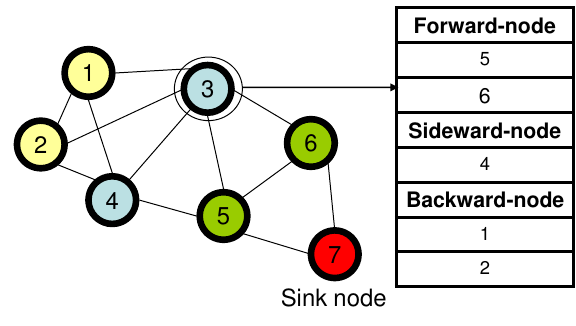
Figure 4. Classification of neighboring nodes at node 3.